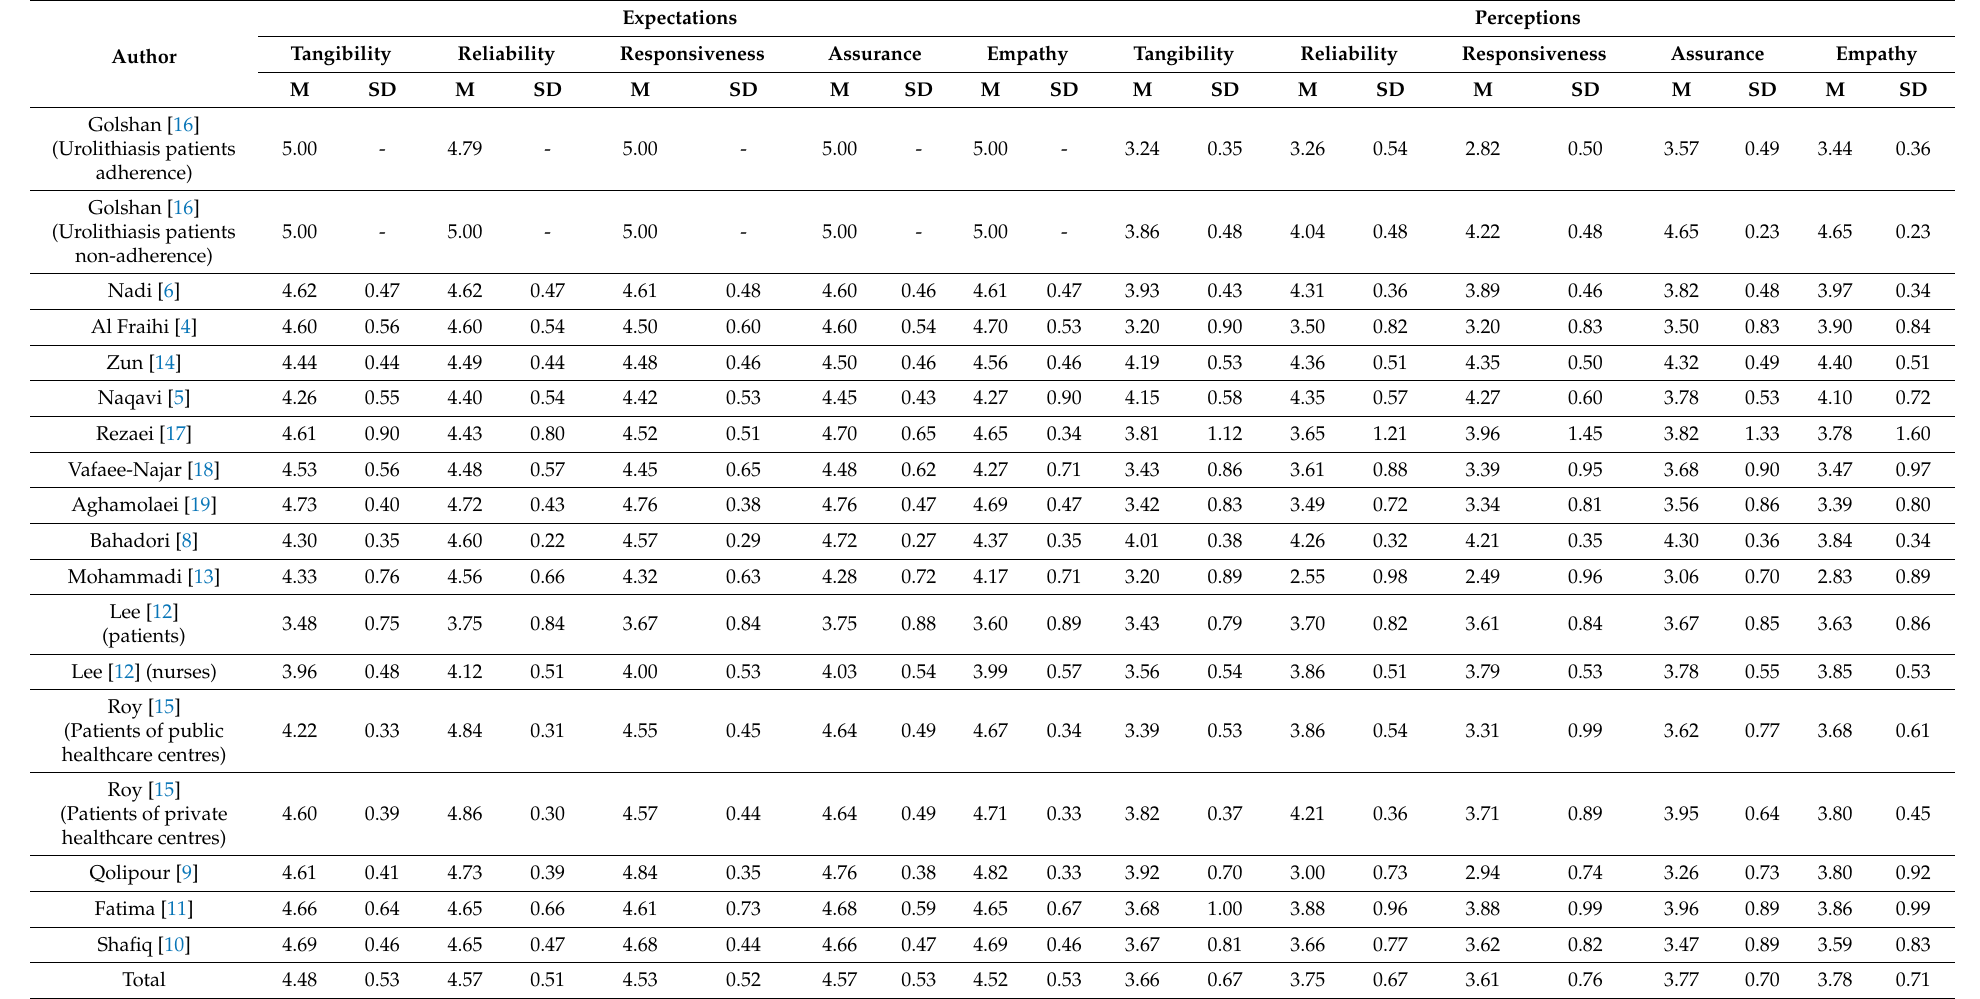
Table 2. The mean results of expectation and perception for the total